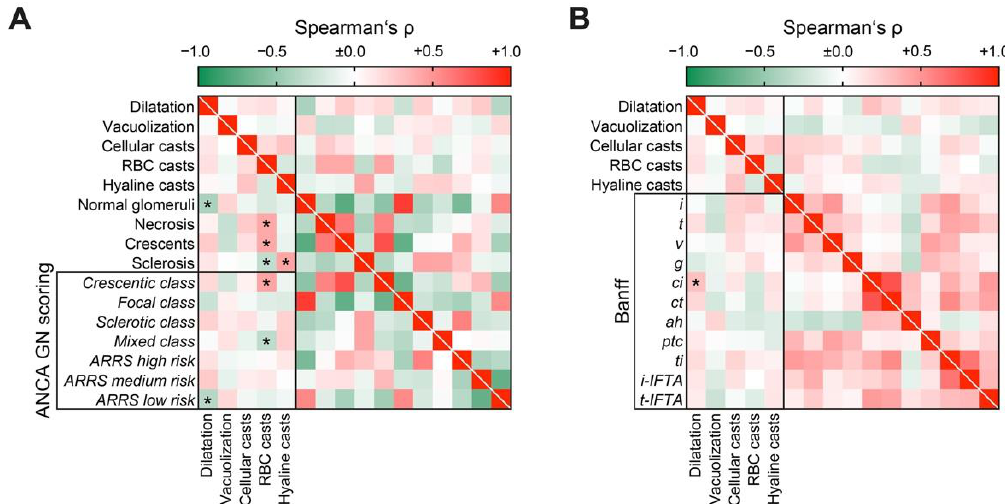
Figure 5. Acute tubular injury patterns correlate with active ANCA GN, whereas tubular lesions reflecting later stages of kidney disease correlated with chronic glomerular lesions: ( A ) Association between tubular injury lesions and histopathological, findings are shown by heatmap reflecting mean values of Spearman’s ρ , asterisks indicate p < 0.05. ( B ) Association between tubular injury and interstitial lesions analogous to the Banff scoring system are shown by heatmap reflecting mean values of Spearman’s ρ , asterisks indicate p < 0.05. Abbreviations: ah , arteriolar hyalinosis; ANCA, anti-neutrophil cytoplasmic antibodies; ci , interstitial fibrosis; ct , tubular atrophy; g , glomerulitis; GN, glomerulonephritis; i , interstitial inflammation; i-IFTA , inflammation in IFTA; t , tubulitis; ptc , peritubular capillaritis; RBC, red blood cell; ti , total inflammation; t-IFTA , tubulitis in IFTA; v , intimal